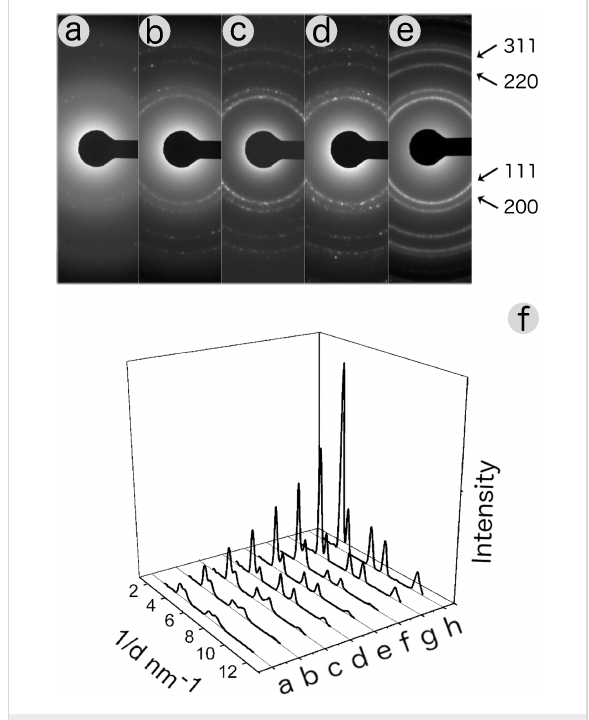
Figure 5: SAED patterns of the colloidal solutions obtained (a) without ammonia and (b–e) with 1, 10, 100 and 1000 ppm ammonia. Panel (f) shows the intensity of the diffraction profiles (a) without ammonia and (b–h) with 0.01, 0.1, 1, 5, 10, 100 and 1000 ppm